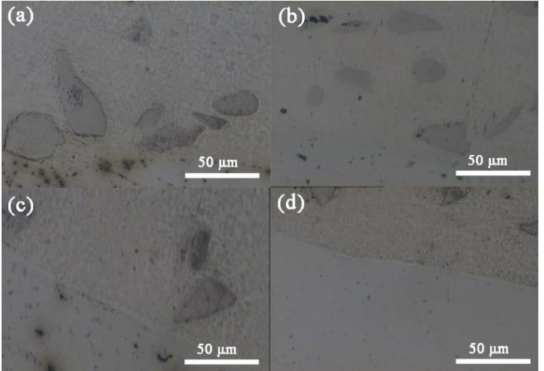
Figure 4. The different contents of the Fe-based amorphous alloy of the binding quality to the